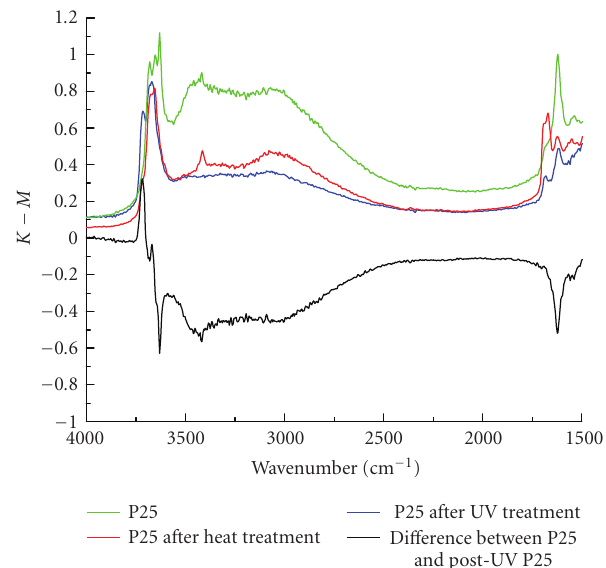
Figure 1: DRIFT spectra showing the e ff ect of heating (to 200 ◦ C) and UV irradiation on P25 TiO 2 powder in vacuoin presence of hole scavenger